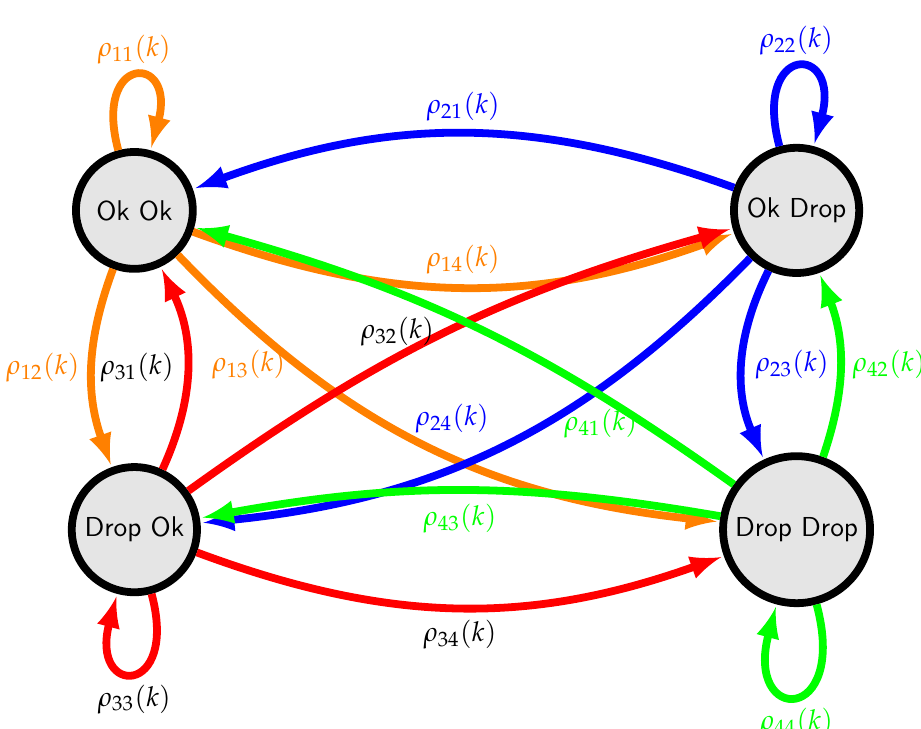
Figure 3. Graphic representation of the network states modeled as a Markov chain where the mode “Ok Ok” denotes that the networks responsible for transmitting the measurement of both sensors are operating on the nominal state, the mode “Ok Drop” represents the situation where there is a problem in the network in charge of transmitting the measurements of the second tank, the mode “Drop Ok” represents a failed transmission of the first tank measurements, and the mode “Drop Drop” stands for the case when both networks present some issues.